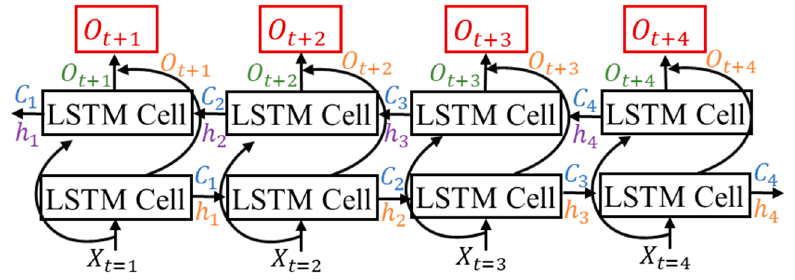
Figure 7. Illustration of Bi-LSTM in our proposed framework.